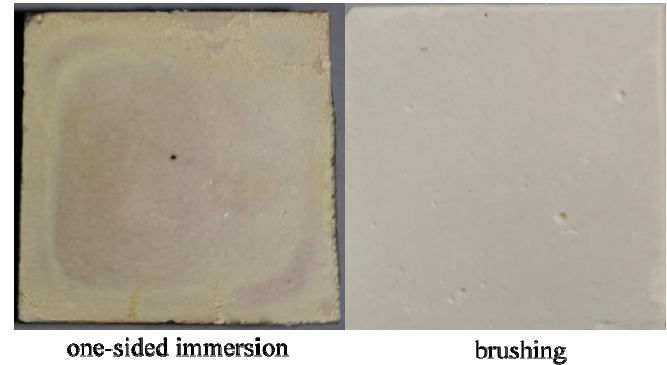
Figure 10. Surface treatment of cement by the one-sided immersion method and brushing method.